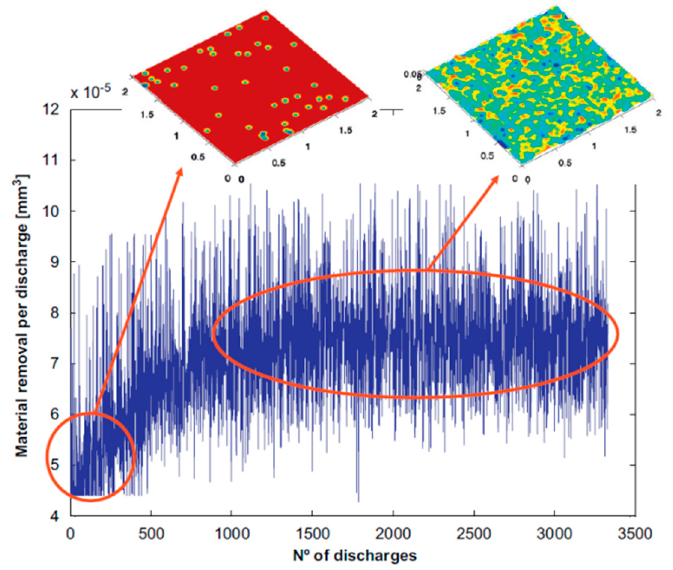
Figure 13. Variation of volume of material removed per discharge as the operation progresses [106].